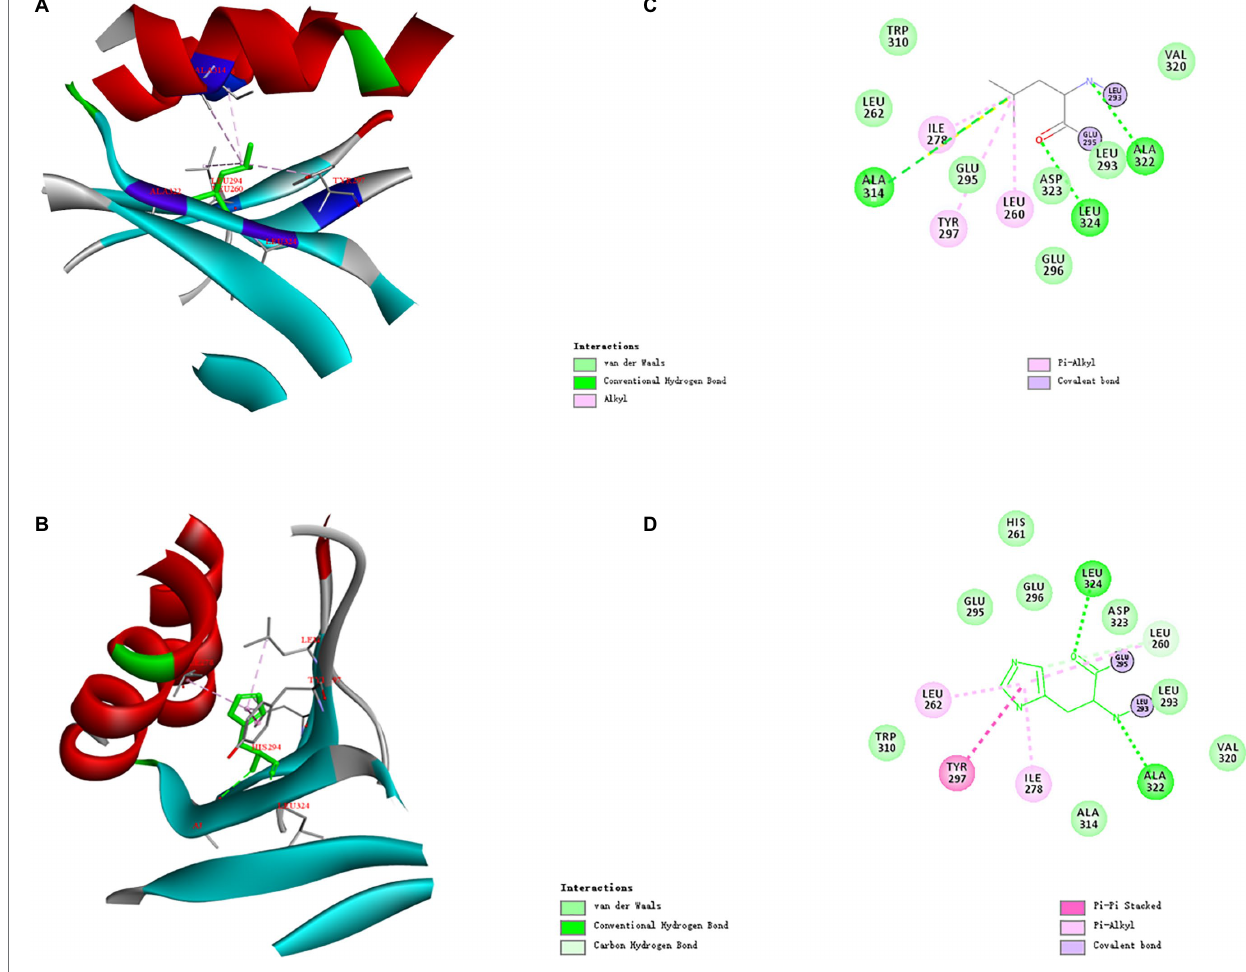
FIGURE 7 | Overall structure and modeled complex structures of ManAK (A) and ManAK L294H (B) in position 294. The amino acid residues around position 294 are indicated in red. The interactions between them are represented by a dashed line. Interaction analysis of amino acid site ManAK (C) and ManAK L294H (D) . The green dashed line indicates Conventional Hydrogen Bond interaction; the pink dashed line indicates Alkyl and Pi-Alkyl interaction; the deep pink dashed line indicates Pi-Pi stacked interaction. Amino acid residues that form van der Waals interactions with amino acid in position 294 are indicated in light green balls and Covalent bond are indicated in